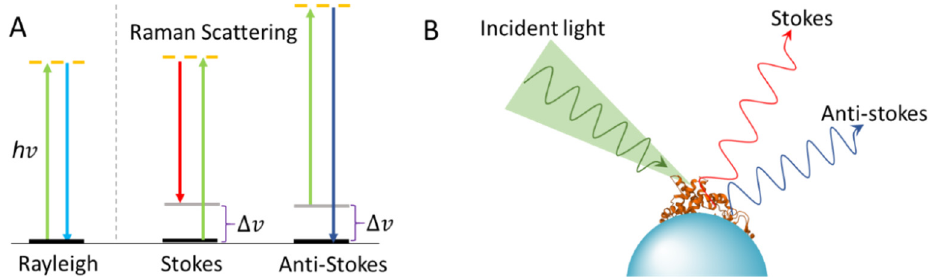
Figure 1. Light scattering and SERS. ( A ) Energy changes of Rayleigh, Stokes, and anti-Stokes scattering. ( B ) Enhanced Raman scattering of a protein adsorbed onto a nanoparticle.